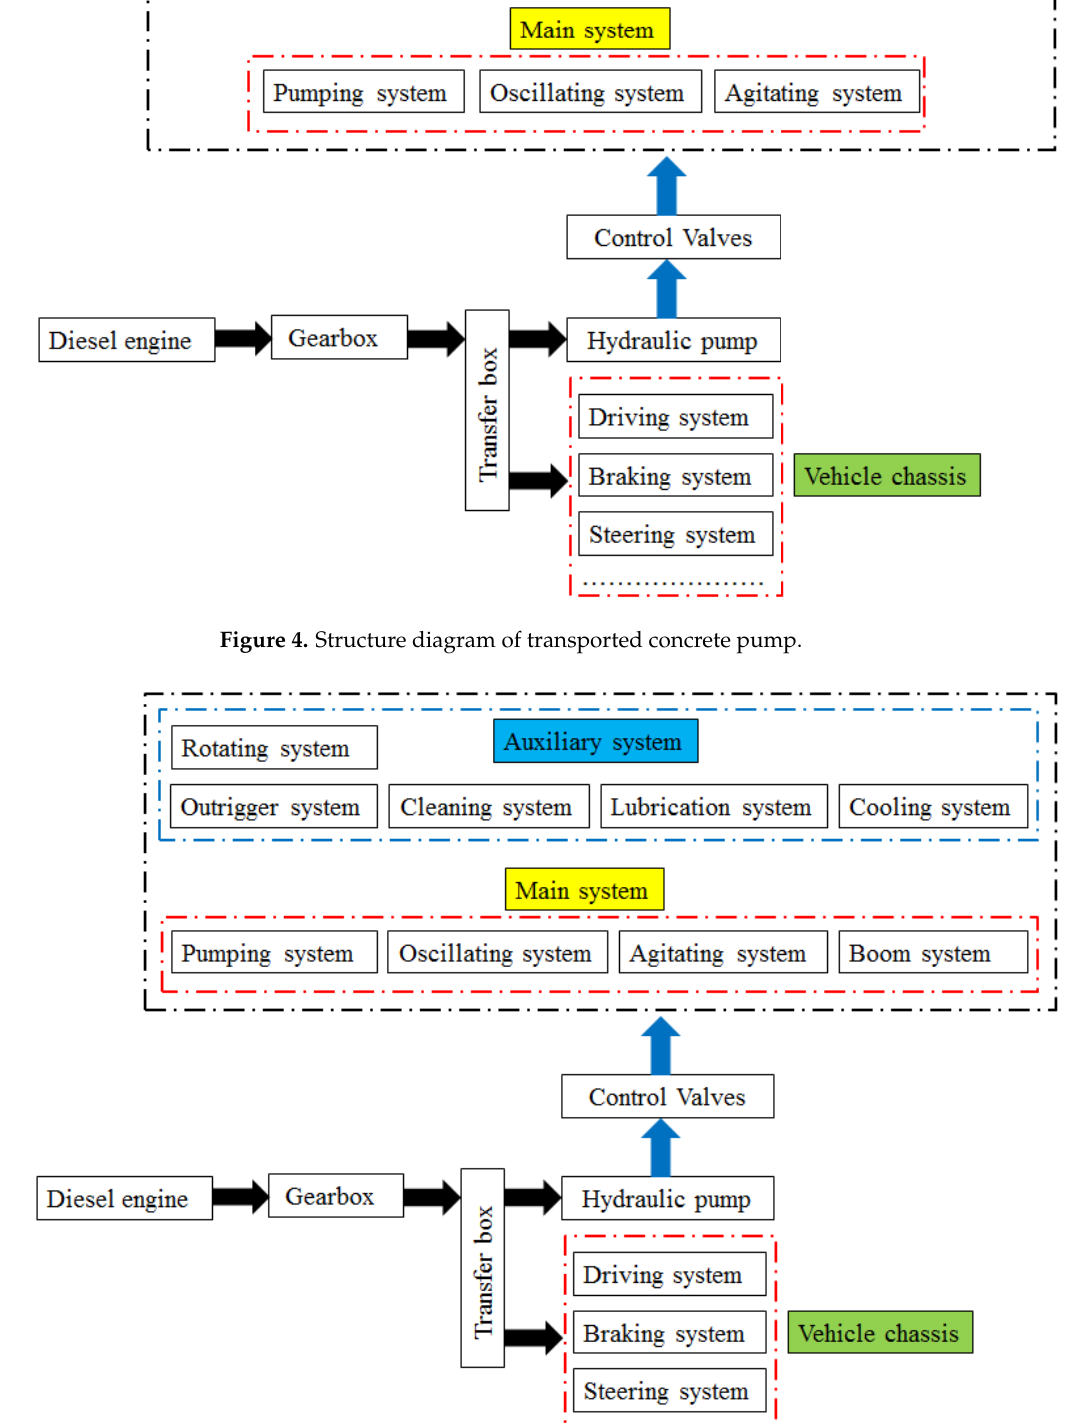
Figure 6. Boom system of truck-mounted concrete pump [30]. Similar to the transported concrete pump, the truck-mounted concrete pump also has two work conditions: driving condition and pumping condition. In addition, when working in the pumping condition, the hydraulic motor will drive the rotating platform to rotate and the cylinders linking booms will drive the corresponding boom to extend or retract so that it can ensure that fresh concrete can be transported to an expected position.